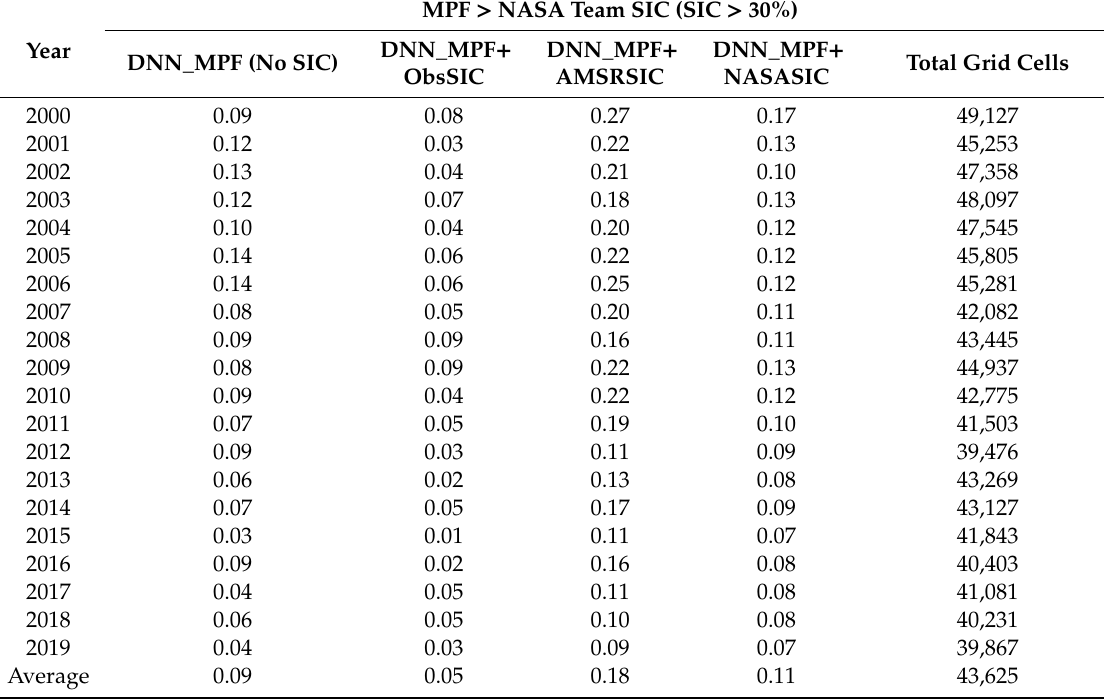
Table 4. The percentage of the grid cell (bad retrieval) with MPF relative to grid greater than NASA Team